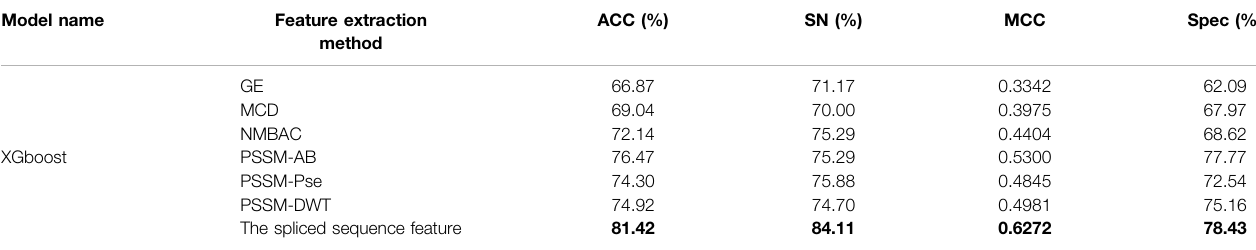
TABLE 3 | Performance of PDB1075 using different feature extraction methods in XGBoost. Model name